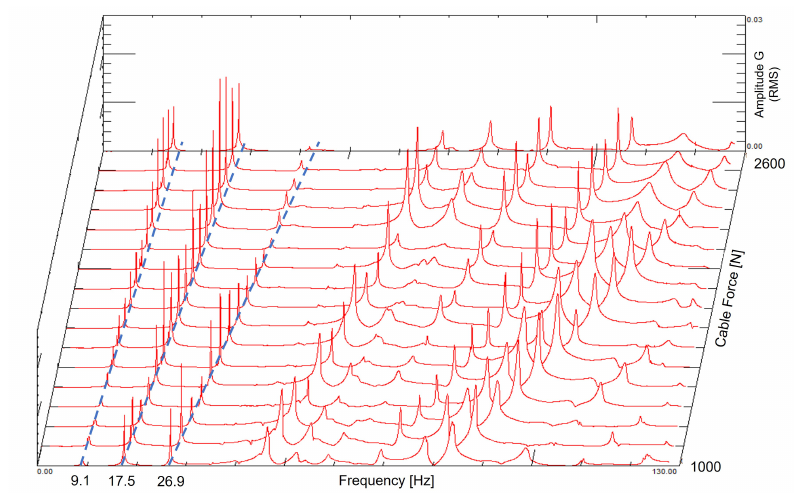
Figure 12. Measured natural frequencies as a function of the cable load (3-D format).